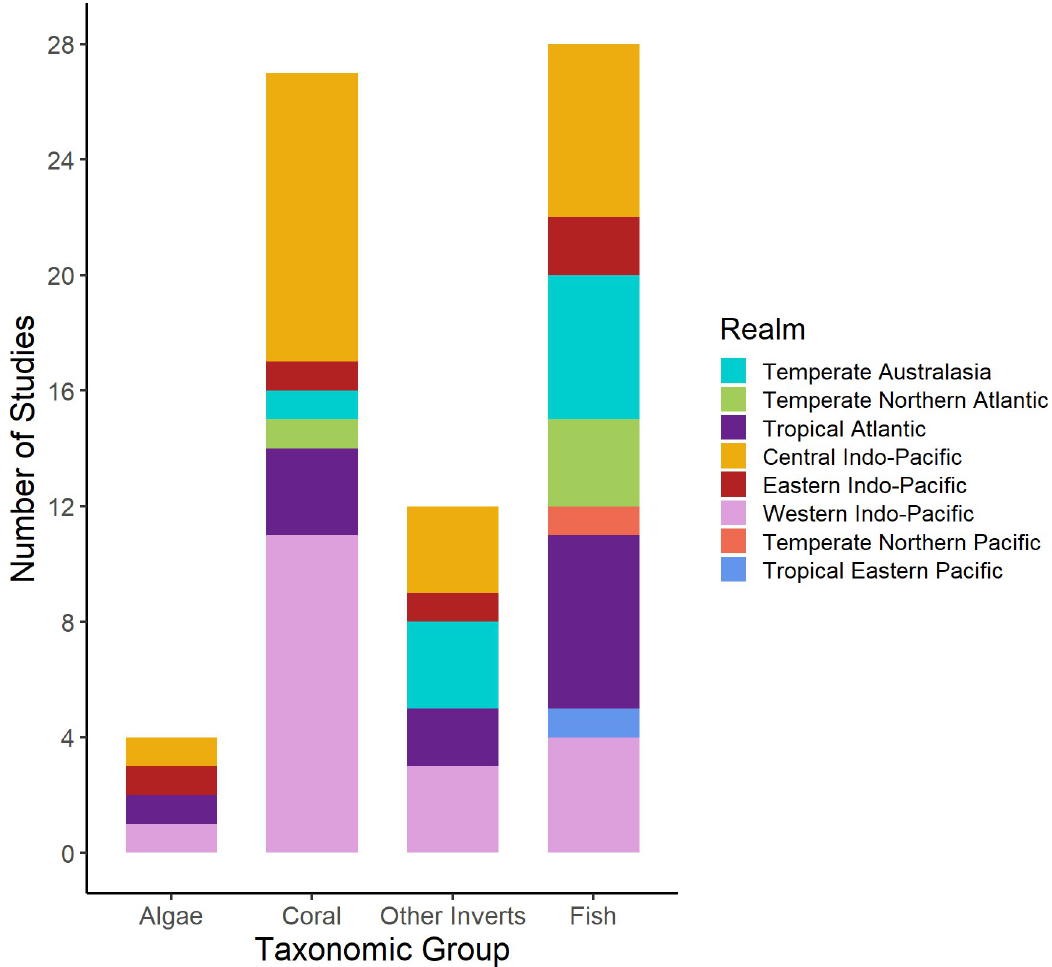
Fig 4. Number of studies monitoring conservation success of an AR (n = 51 studies) that measured ecological response variables for 4 taxonomic groups (Benthic Algae, Coral, Other Invertebrates, Fish) for each marine realm. See Fig 2 for map of